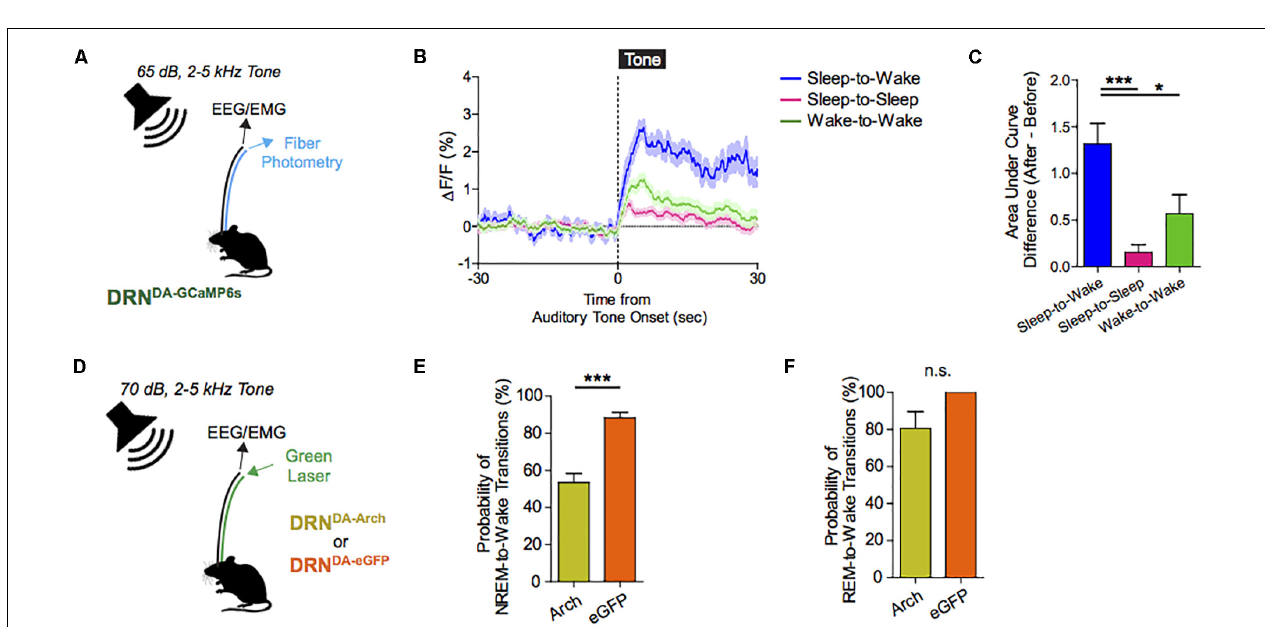
FIGURE 8 | Dorsal raphe nucleus dopaminergic (DRN DA ) activity escalates in response to salient stimuli irrespective of valence; correlates with sleep–wake states, and can bidirectionally modulate arousal. (A) Experimental paradigm. (B) Auditory cues are associated with time-locked increases in DRN DA activity. (C) DRN DA activity increase, as indexed by the difference in the area under the curve between before and after tone presentation, was larger when auditory tone induced sleep-to-wake transitions than when it was turned on while awake or when it failed to cause sleep-to-wake transitions ( n = 7 DRN DA − GCaMP6s ; One-way ANOVA, F 2 , 18 = 10.79, p < 0.001, Post hoc Bonferroni analysis, ∗∗ p < 0.01). (D) Experimental paradigm. (E) Time-locked DRN DA inhibition decreased the probability of NREM-to-wake transitions upon auditory cues ( n = 6 DRN DA − Arch , n = 4 DRN DA − eGFP ; Two-tailed, unpaired t -test, ∗∗∗ p < 0.001. (F) No significant change in the probability of REM-to-wake transitions ( n = 6 DRN DA − Arch , n = 4 DRN DA − eGFP ; Two-tailed, unpaired t -test, p > 0.1).